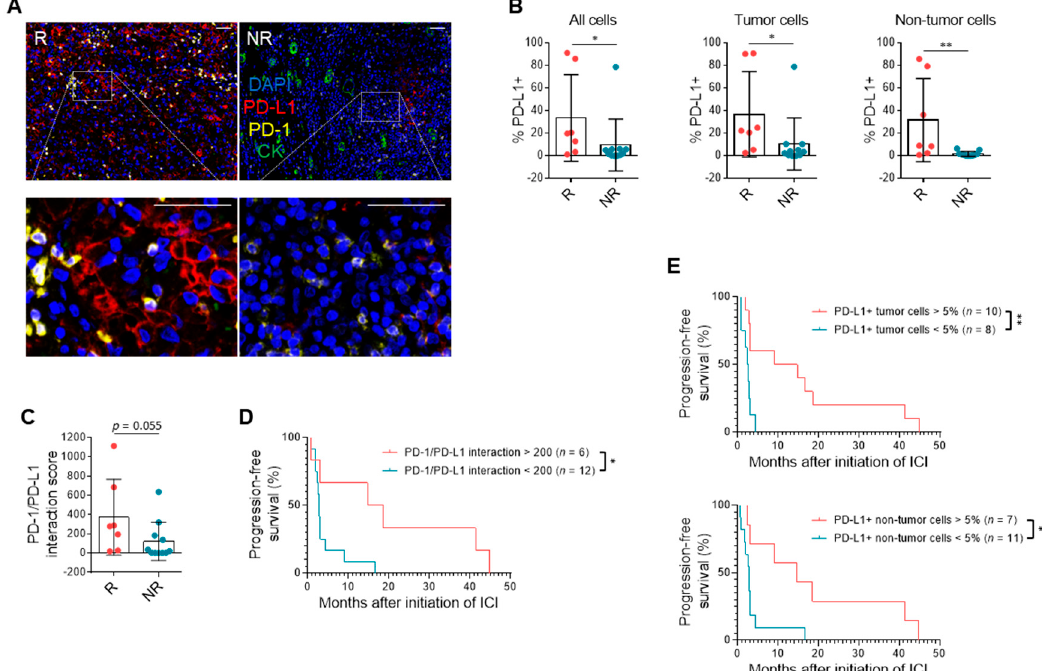
Figure 2. PD-L1 expression is associated with response to anti-PD-1/PD-L1 therapy. ( A ) Representative mIF images of primary tumors stained for DAPI (blue), PD-L1 (red), PD-1 (yellow), and cytokeratin (CK) (green) from a responder and non-responder. Scale bar: 50 µ m. ( B ) Quantification of PD-L1 expression on all cells, tumor cells, and non-tumor cells in primary tumors from responders compared to non-responders. Data shown are averages ± SD. * p < 0.05, ** p < 0.01, unpaired Mann–Whitney U-test ( n = 7, 10). ( C ) PD-1/PD-L1 interaction scores in responders versus non-responders. Data shown are averages ± SD. Unpaired Mann–Whitney U-test ( n = 7, 10). ( D ) PFS of patients based on PD-1/PD-L1 interaction score threshold of 200. * p < 0.05, log-rank test ( n = 6, 12). ( E ) PFS of patients based on PD-L1 expression of tumor ( n = 10, 8) or non-tumor cells ( n = 7, 11) with a threshold of 5%. * p < 0.05, ** p < 0.01, log-rank test.